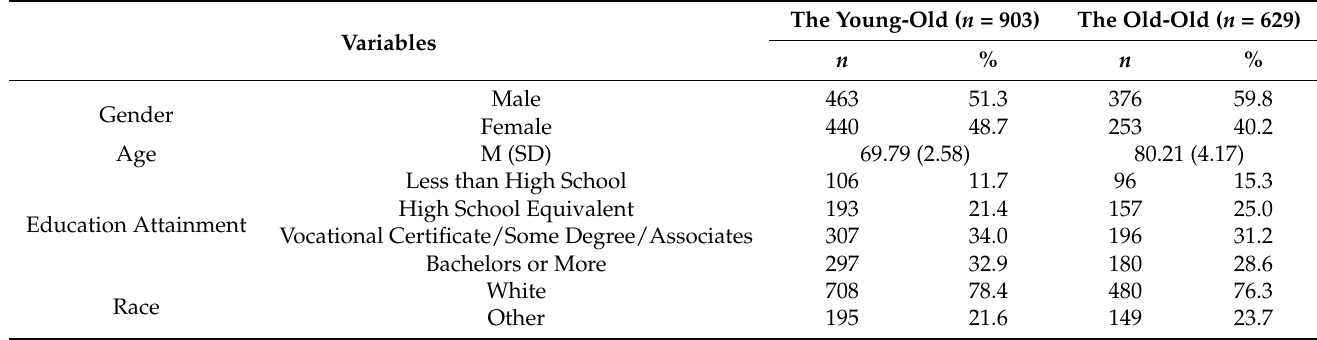
Table 1. Descriptive Statistics of the Young-Old and the